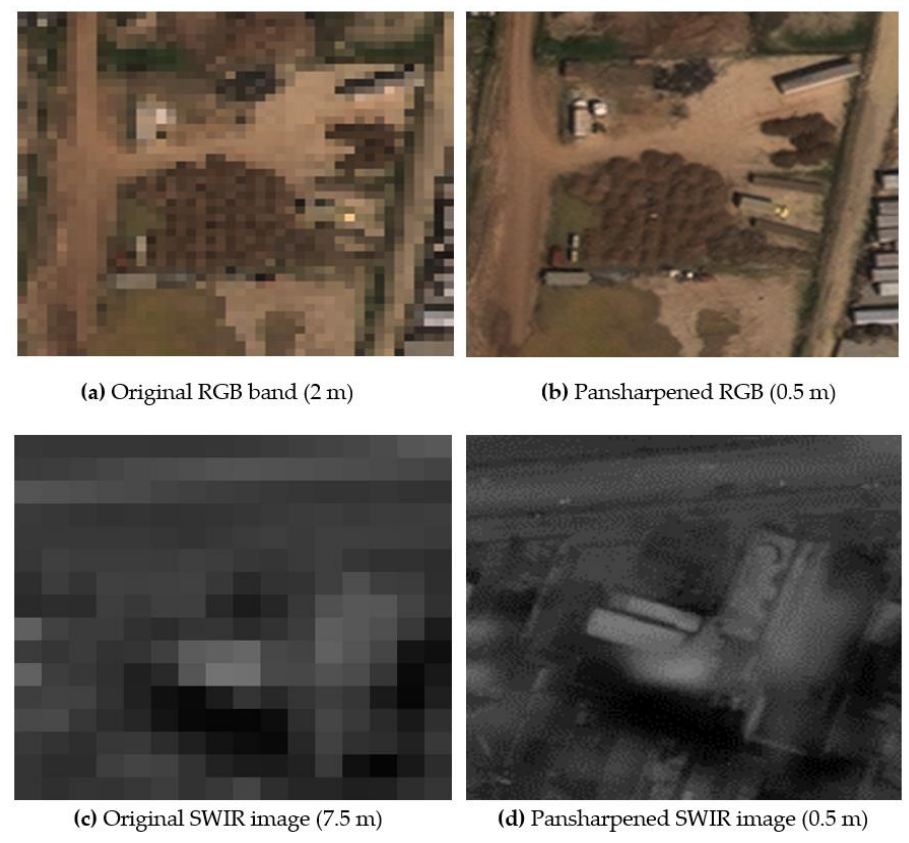
Figure 8. RGB and SWIR images before and after pansharpening.